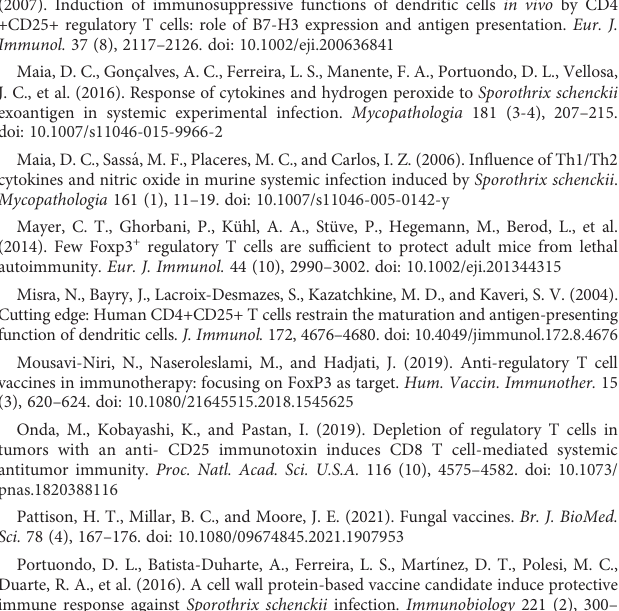
in a small number of animals. Morphological characteristic of the yellowish- white nodules in the liver of S. brasiliensis- infected mice, can be seen in (Batista-Duharte et al.,